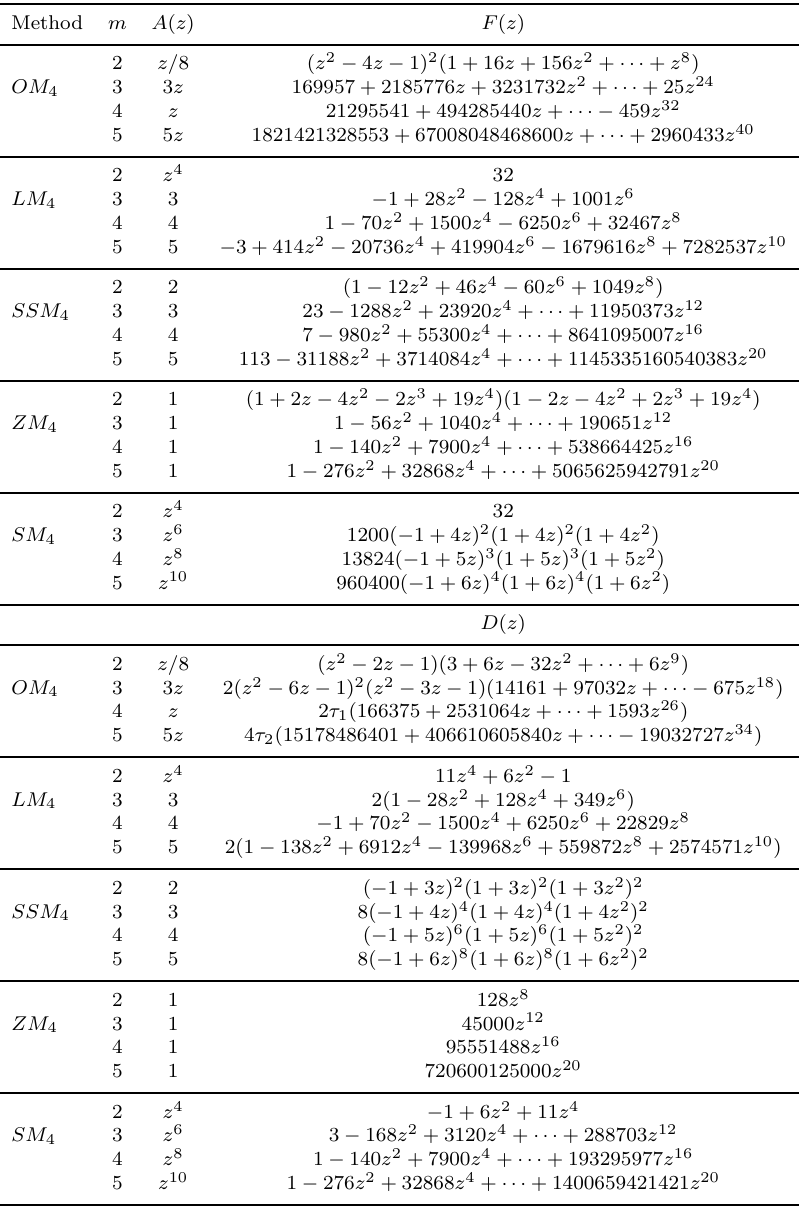
Table 1. A ( z ) ,F ( z ) and D ( z ) of various fourth-order methods for typical cases Method m A ( z